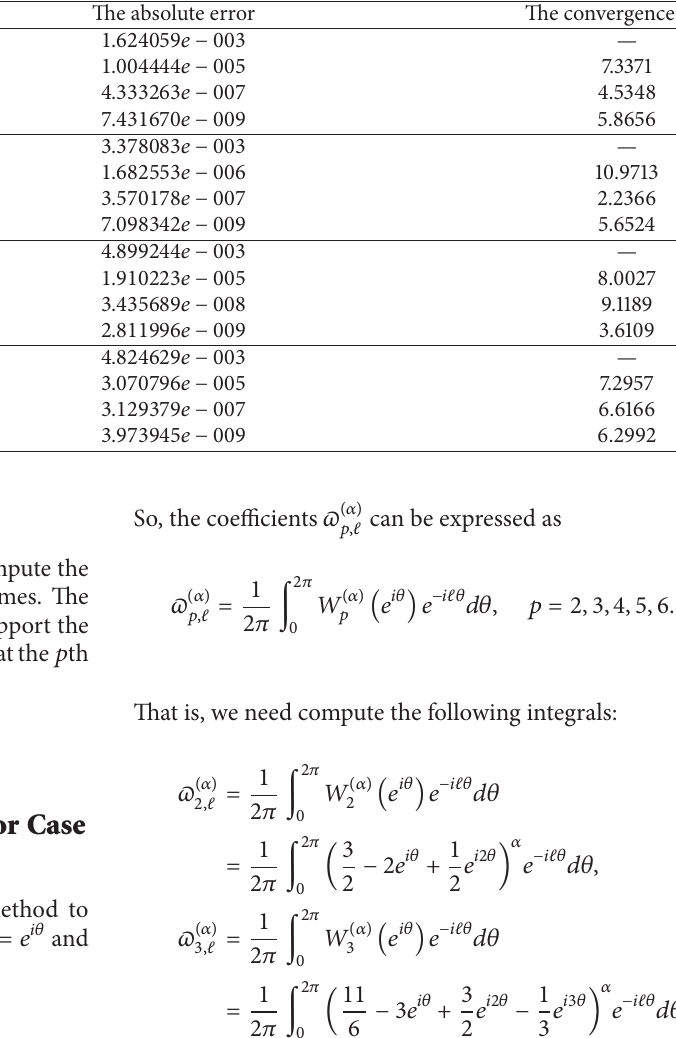
Table 8: The numerical results of the Example 9 by formula (14) with 𝑝 = 6